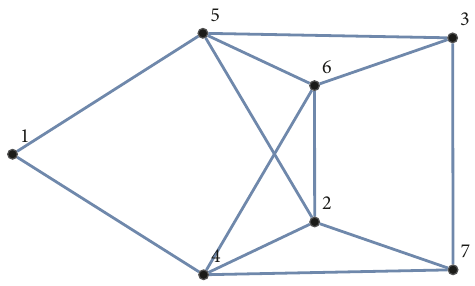
Figure 1: The communication topology of multiagent network, each number stands for an agent, and edge shows communication among agents.